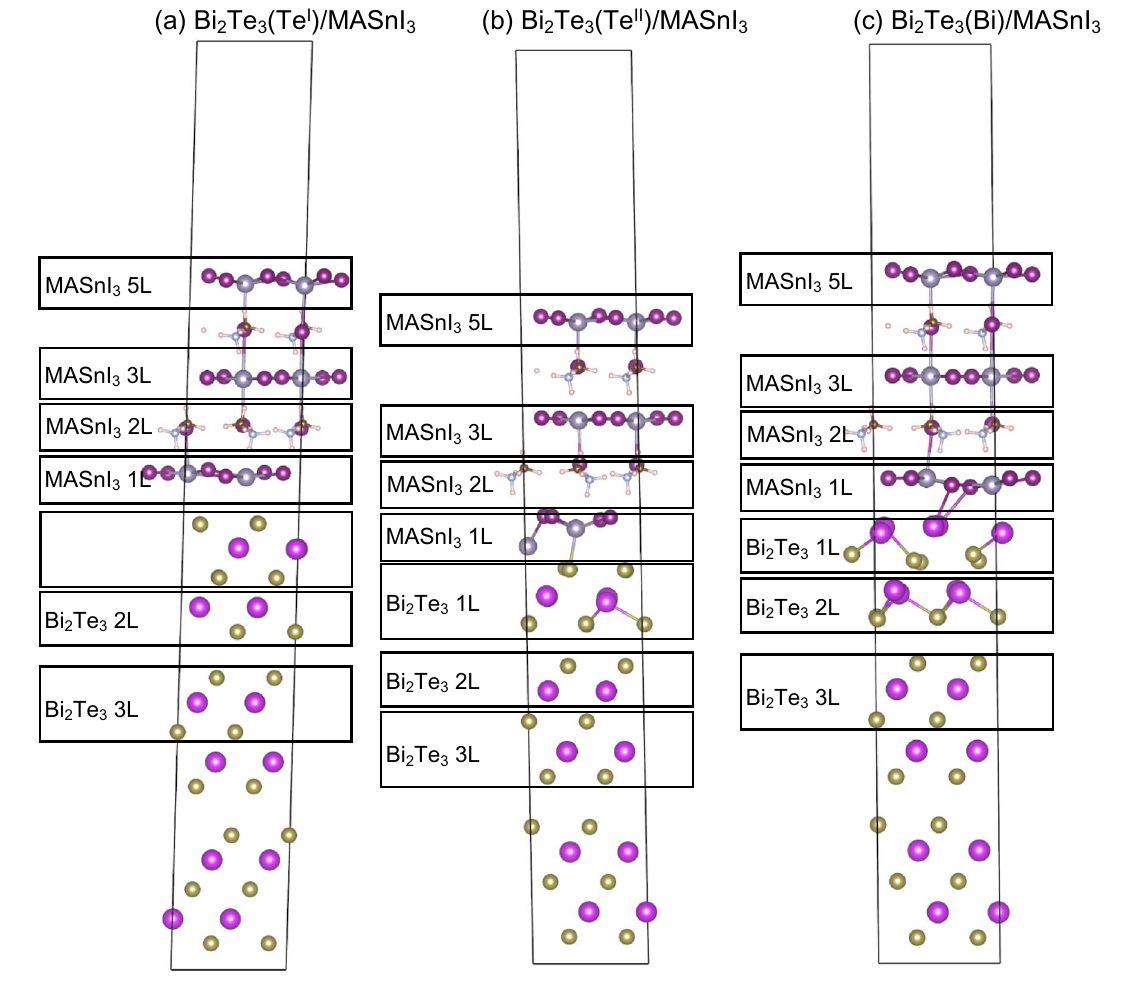
Figure 5. Decomposition method for each layer in the ( a ) Bi 2 Te 3 (Te I )/MASnI 3 , ( b ) Bi 2 Te 3 (Te II )/MASnI 3 , and ( c ) Bi 2 Te 3 (Bi)/MASnI 3 interface structures and the atoms included in each layer.